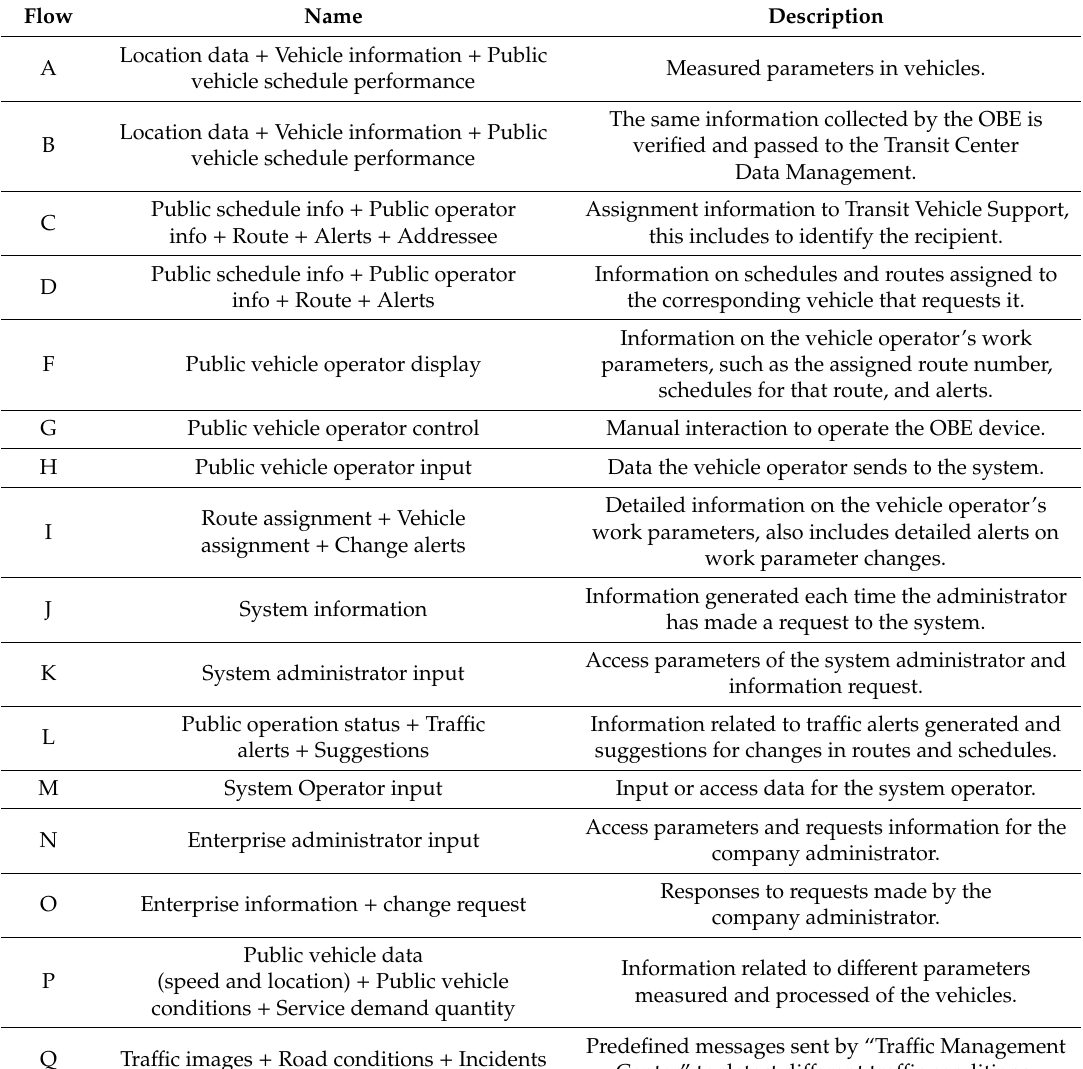
Table 4. Information flow of the ITS architecture